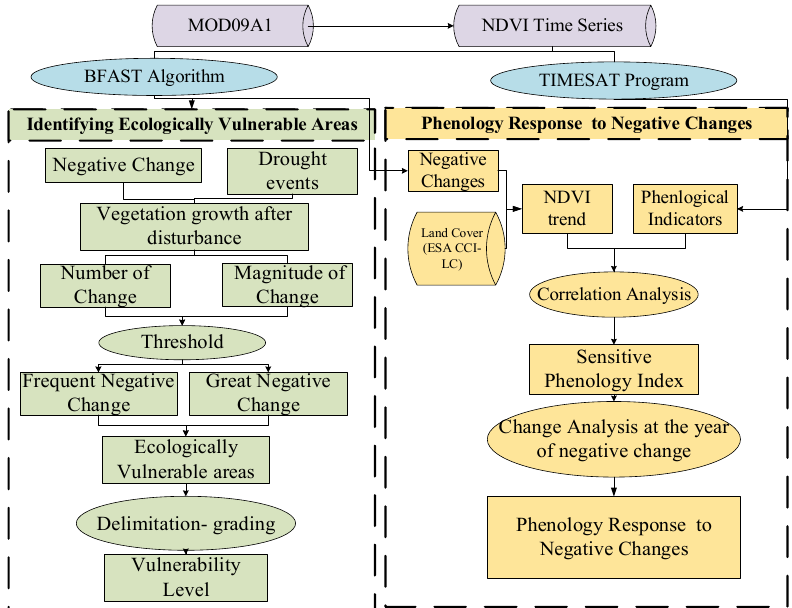
Figure 2. Flowchart of the identification of ecologically vulnerable areas and exploration of the phenological response mechanism for disturbances using Breaks for Additive Season and Trend (BFAST) and TIMESAT from the remote sensing (RS) time series.